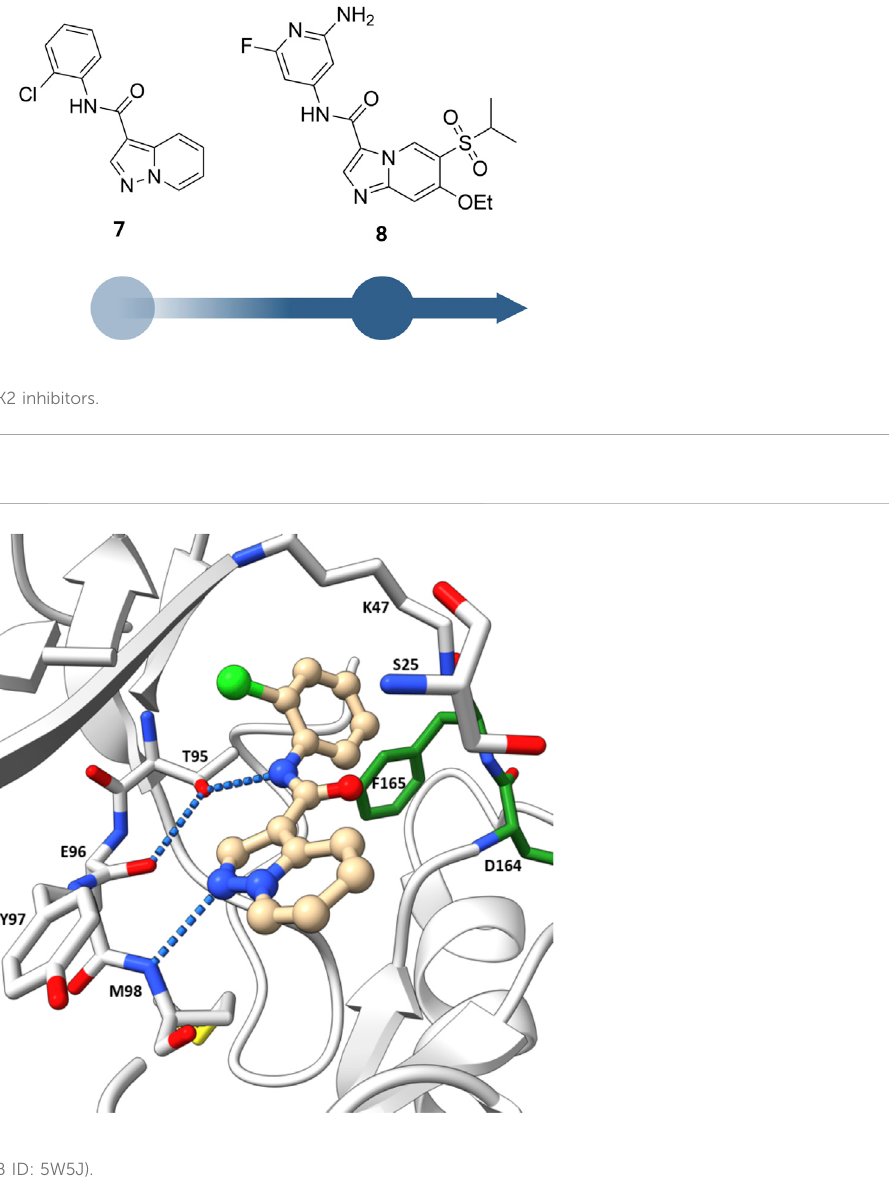
Scaffold hopping (i.e., quinoline to quinazoline; indazole to benzothiazole) resulted in the 4-aminoquinazoline series (4, Figure 6; Figure 7D) that had a divergent structure-activity relationship (SAR) in inhibitory activities for RIPK2 and hERG ion channel (Haile et al., 2019). The quinazoline series exhibited a better safety pro fi le compared to 3 as almost no hERG inhibitory activity was detected (IC 50 > 30 μ M). 4 was reported as the lead molecule in these studies (IC 50 = 5 nM) with reasonable PK parameters in rat, dog, and minipig (Table 1). However, high dose safety assessment studies in rats showed a lack of dose- exposure linearity, which was likely caused by poor solubility in fasted state simulated intestinal fl uid. Therefore, 4 likely precipitated in the gastrointestinal (GI) tract as the dose increased. Since various formulation strategies failed to solve this problem, a prodrug